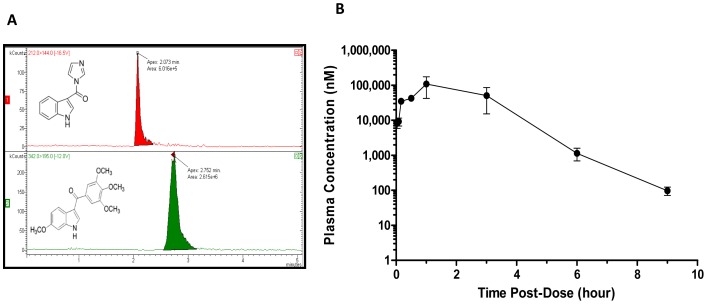
Plasma pharmacokinetics of BPR0L075 in CD-1 mice after administration of drug at 50 mg/kg intraperitoneally.(A) LC-MS/MS analysis of BPR0L075 with chromatogram showing the retention time of internal standard [1-(1H-indol-3-ylcarbonyl)-1H-imidazole] and BPR0L075 as 2.1 and 2.8 min, respectively. (B) The plasma concentration-time curve following BPR0L075 treatment.